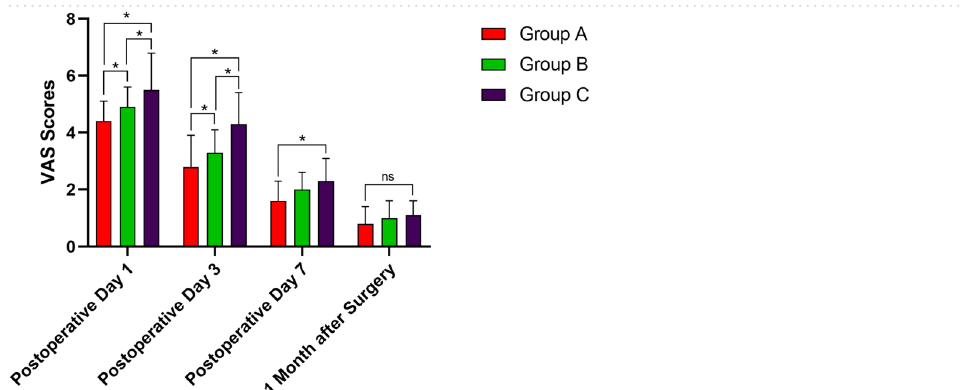
Table 2. Comparison of outcomes among groups. Significant values are in italics. *represents the differences among three groups was statistically significant (P<0.05). Any two values with the same or containing one same letter superscript, means that there is statistical difference between these two groups.